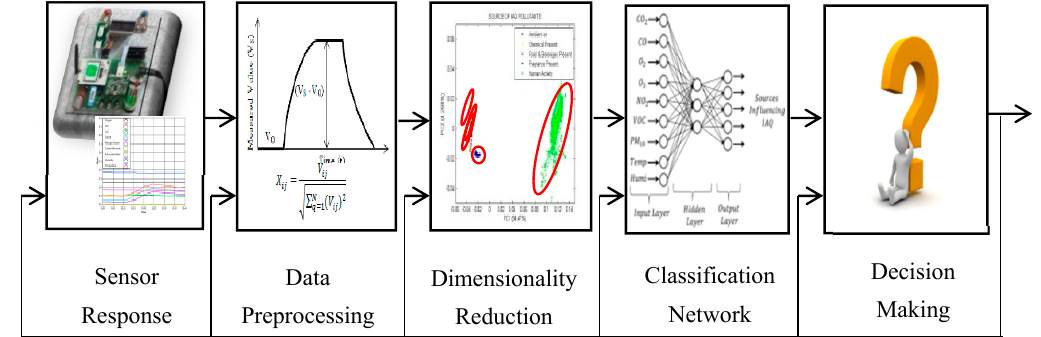
Figure 5. Steps in pattern recognition.